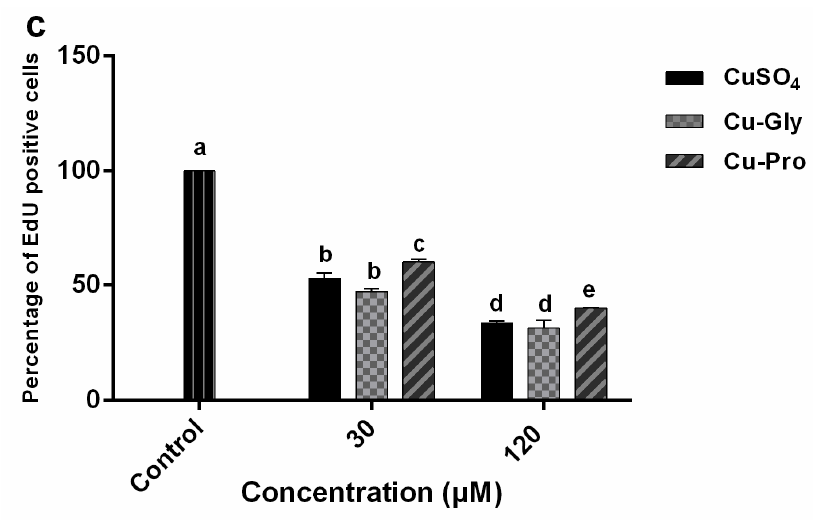
Figure 1. Cell viability in response to different copper concentrations for 10 h. ( a ) Cell counting kit 8 (CCK-8) cell viability assay. ( b ) EdU staining assay. ( c ) Statistical analysis of the percentage of EdU positive cells. The result was represented as a percentage of the control. Data represent mean values ± standard deviation ( n = 4). Significant differences between processing groups are represented by different lowercase letters ( p < 0.05).